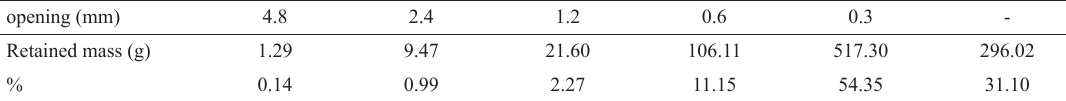
Table 4: Chemical composition of clay opening (mm)